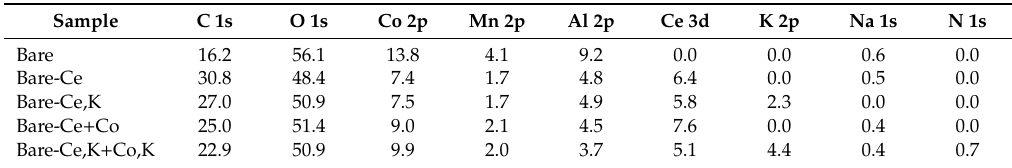
Table 4. Surface molar fractions (mol.%) of the individual components of the examined catalysts (data are corrected to C 1s 284.8